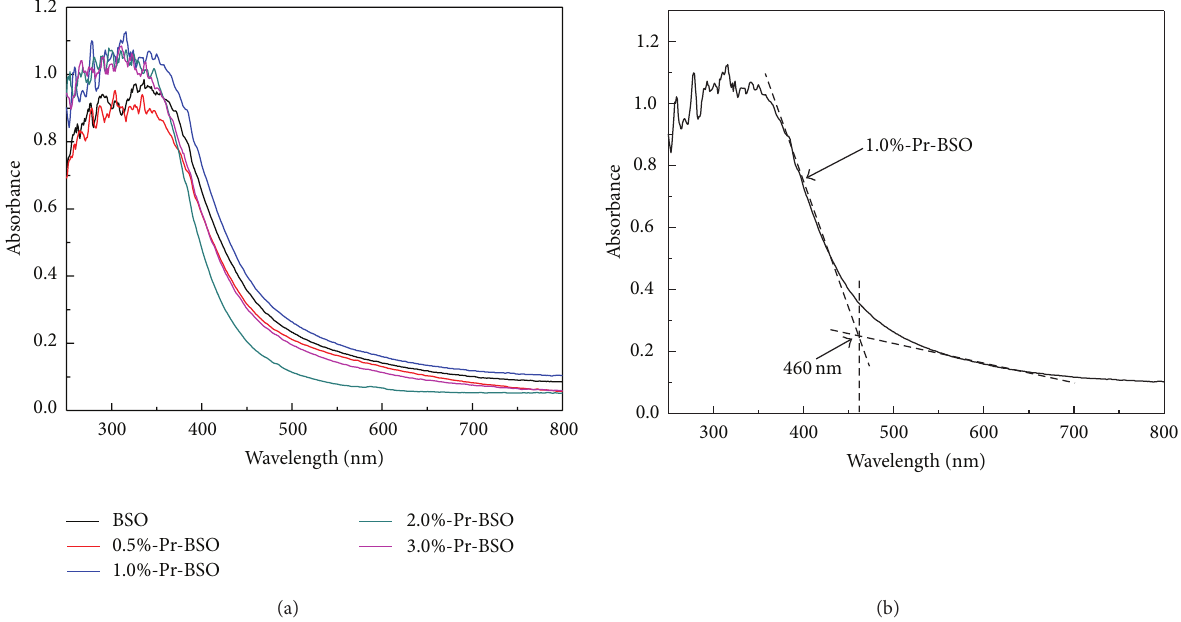
Figure 6: UV-Vis diffuse reflectance spectra of (a) different Pr-doped BSOs and (b) 1%-Pr-BSO.